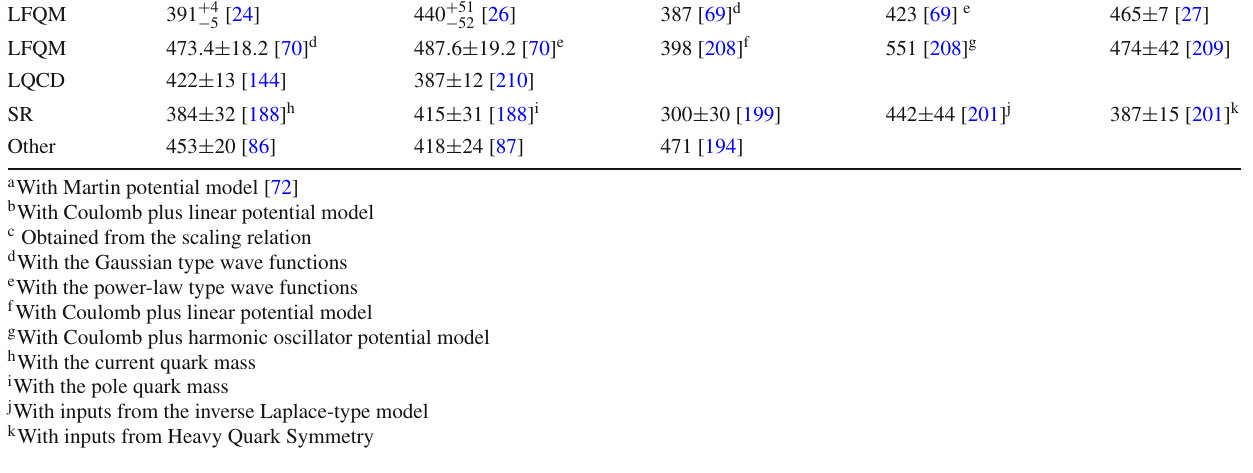
Table 6 The theoretical values of decay constant f B ∗